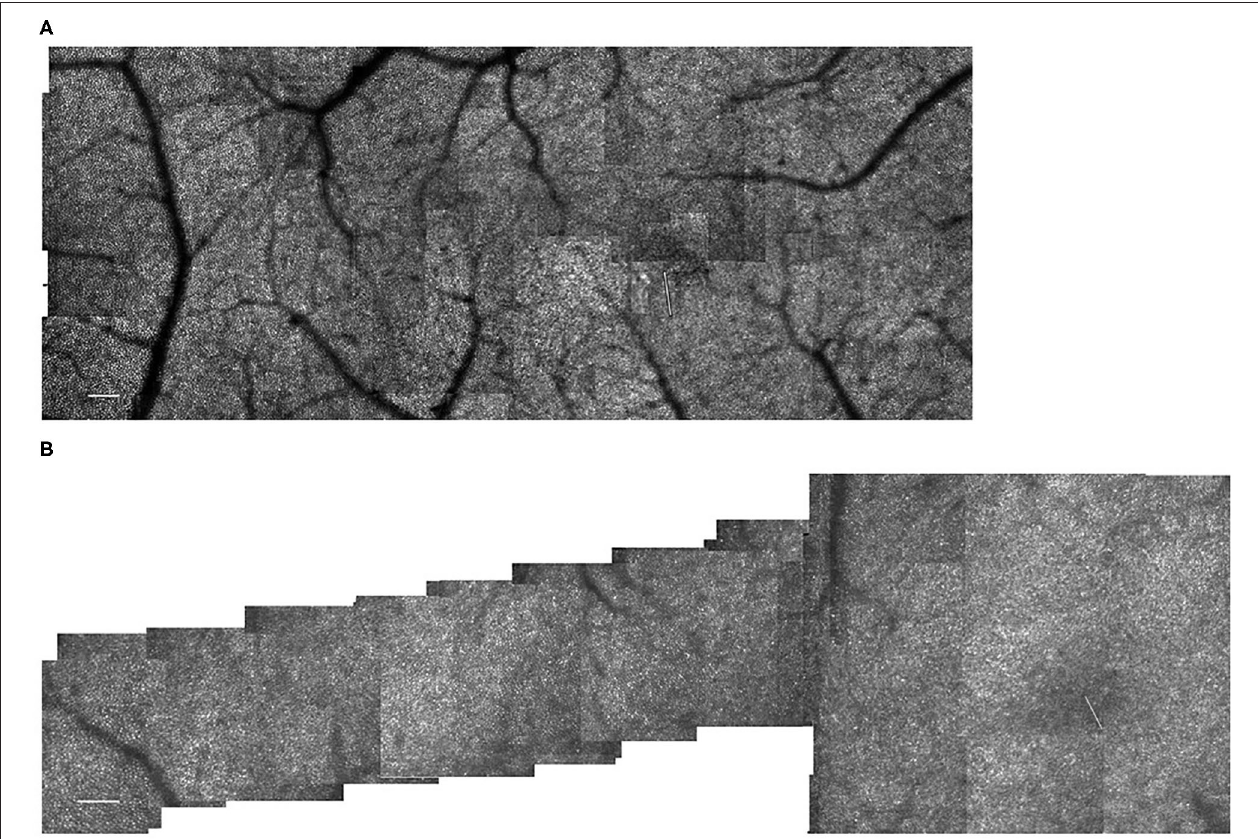
FIGURE 9 | (A) Cone distribution for a 55 yr old female subject from our control population, shown in a montage of cone images with the foveal region on the right. This subject was selected because she had the second lowest cone densities in the sample. Small white scale bar at lower left = 100 microns. White line on the right indicates the foveal center, where the cones are not readily distinguished with this setting on the AOSLO. (B) Cone distribution for a 58 yr old male subject from our control population, shown in a montage of cone images with the foveal region on the right. This subject was selected because he had the highest cone densities in the sample. This subject lacks a foveal avascular zone, having readily imaged capillaries through the foveal center. Small white scale bar at lower left = 100 microns. White line on the right indicates the foveal center, where the cones are not readily distinguished with this setting on the